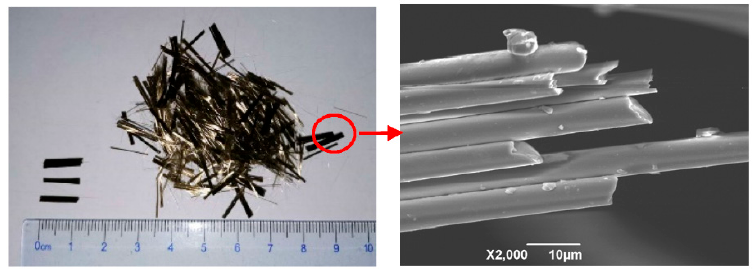
Figure 1. Geometry and SEM micrographs of basalt fibers.